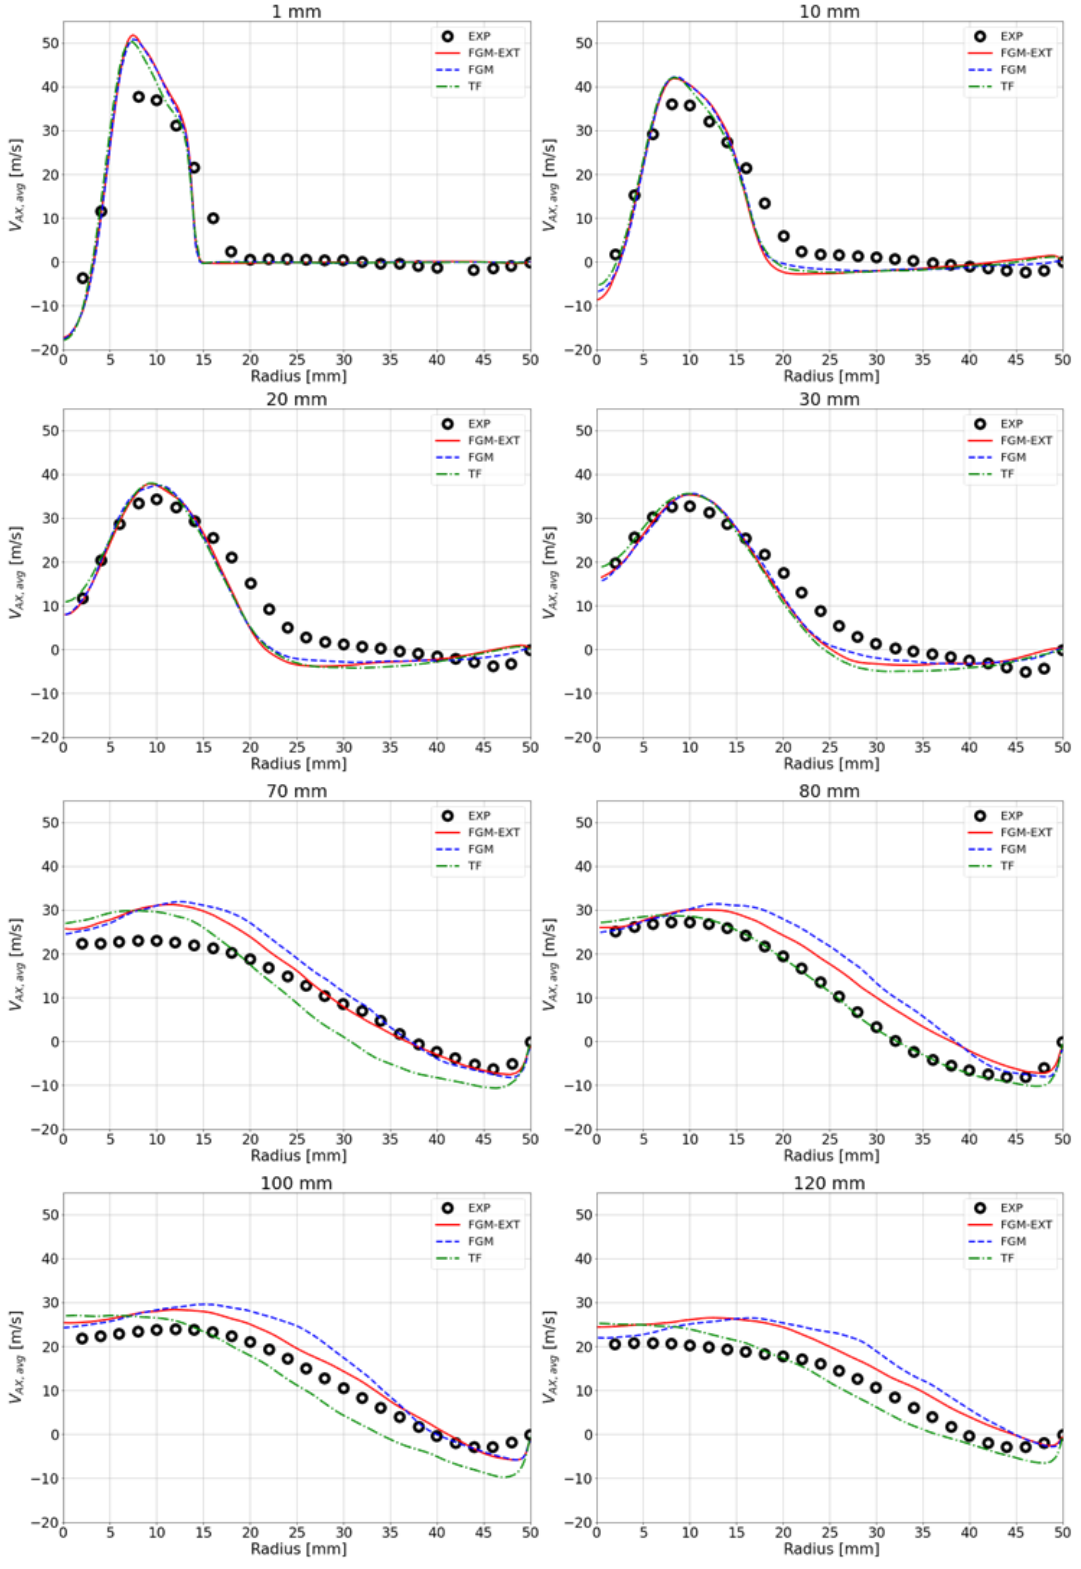
Figure 6. Radial profiles of axial velocity at given planes for the numerical simulations and experi- mental